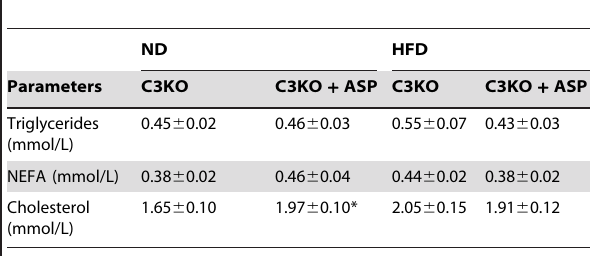
Table 1. Plasma lipid parameters of C3KO and C3KO + ASP